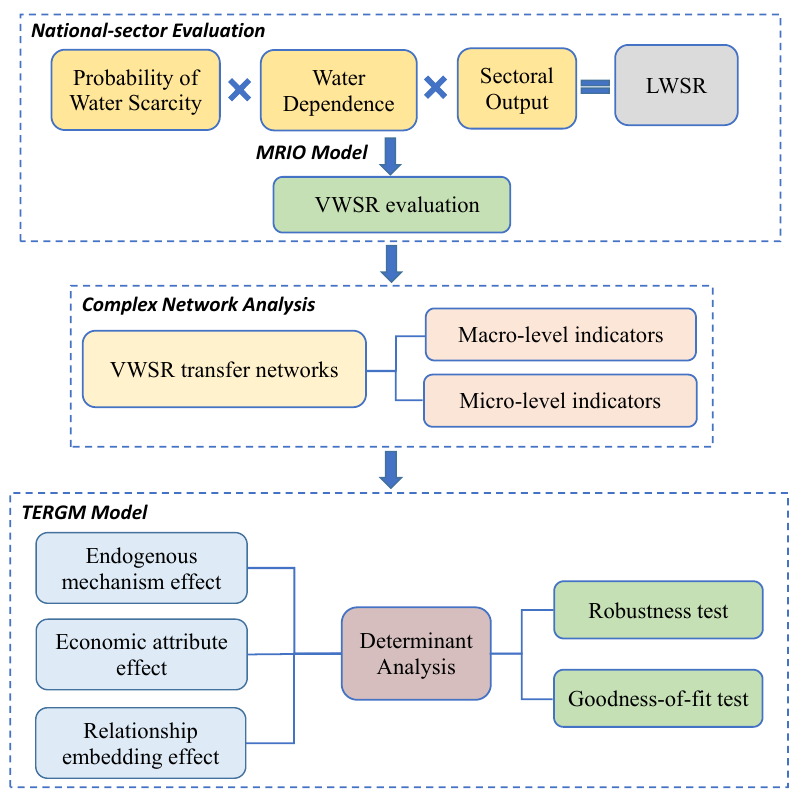
Figure 1. The analysis framework of this